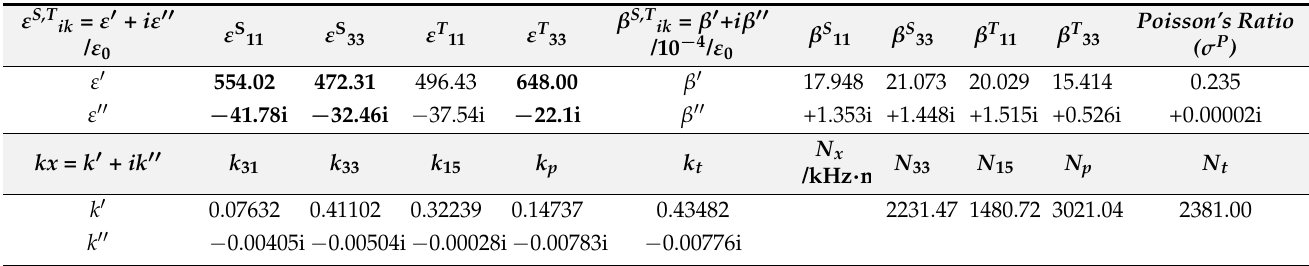
Table 3. Complex dielectric coefficients, Poisson ´ s ratios, electromechanical coupling factors, and frequency numbers of the considered resonances of the PIC700 eco-piezoceramic ( * )